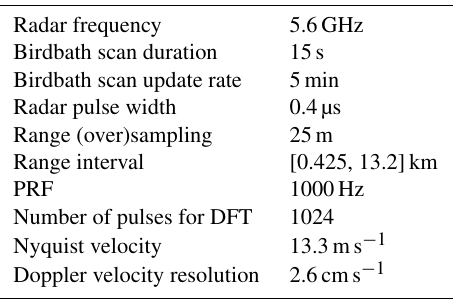
Table 1. Characteristics of the DWD operational birdbath scan and Doppler